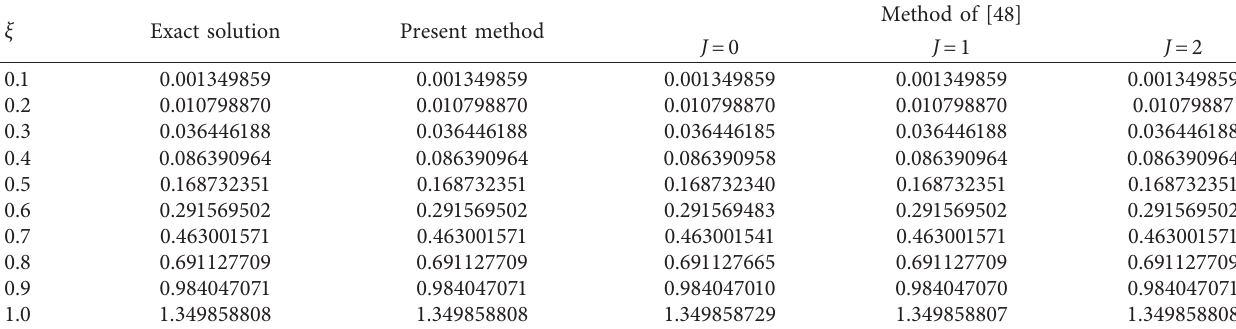
Table 3: For different values of t and ξ , comparison of results for Test Problem 4.2.